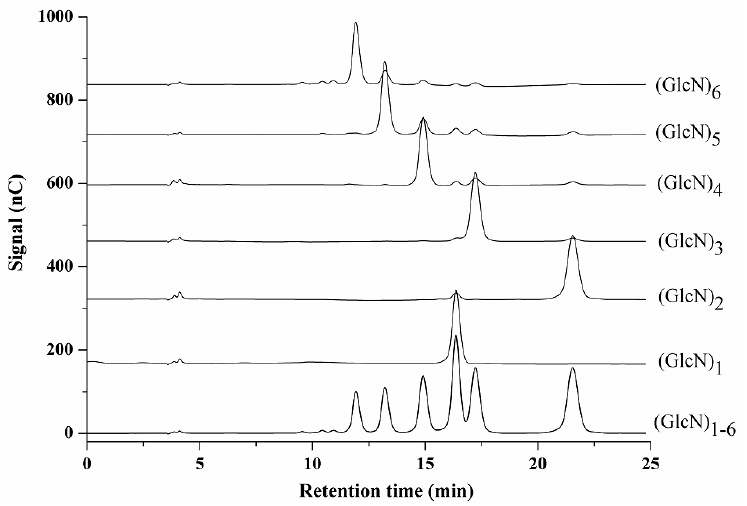
Figure 1. High-performance anion exchange chromatography with pulsed amperometric detection (HPAEC-PAD) chromatograms of (GlcN) 1–6 standards.